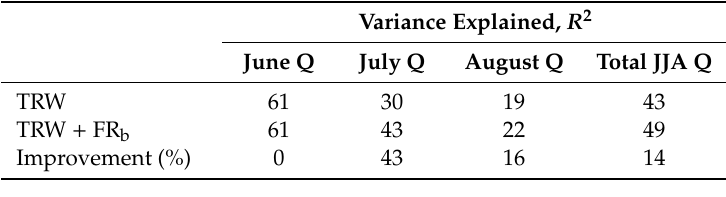
Table 3. Variance explained (adjusted R 2 ) of the TRW and TRW + FR b generalized linear models of